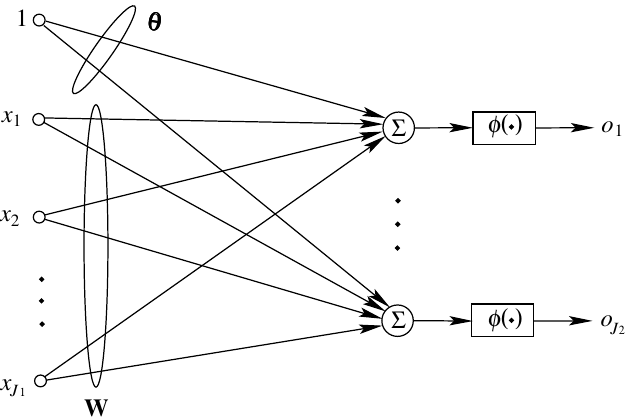
Figure 2. Architecture of the single-layer